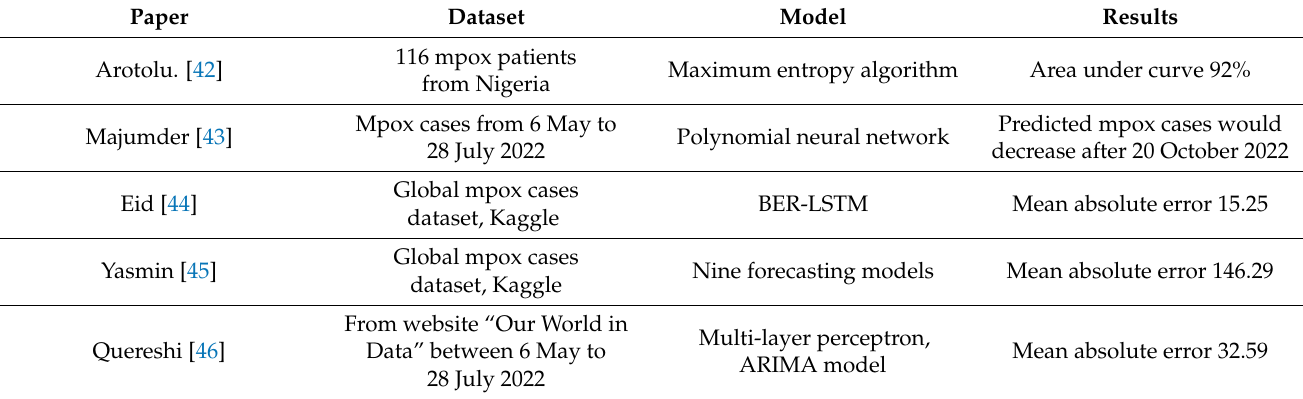
Table 2. Published artificial intelligence-based models for predicting the number of mpox